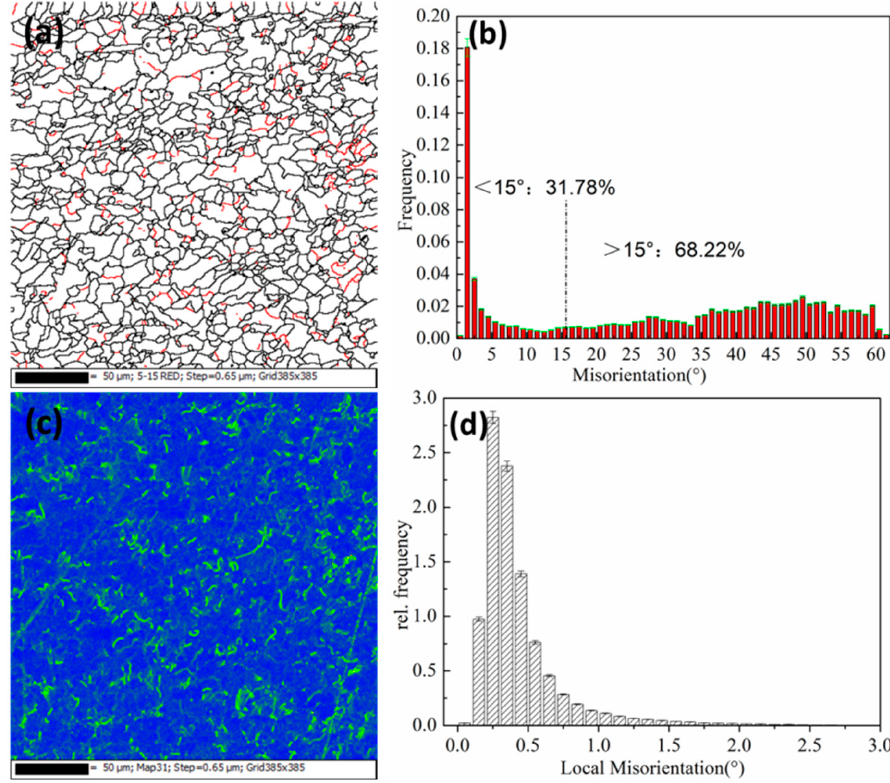
Figure 10. Grain boundary map and local orientation difference at 650 °C. ( a , b ) Grain boundary maps; ( c , d ) Local orientation difference.